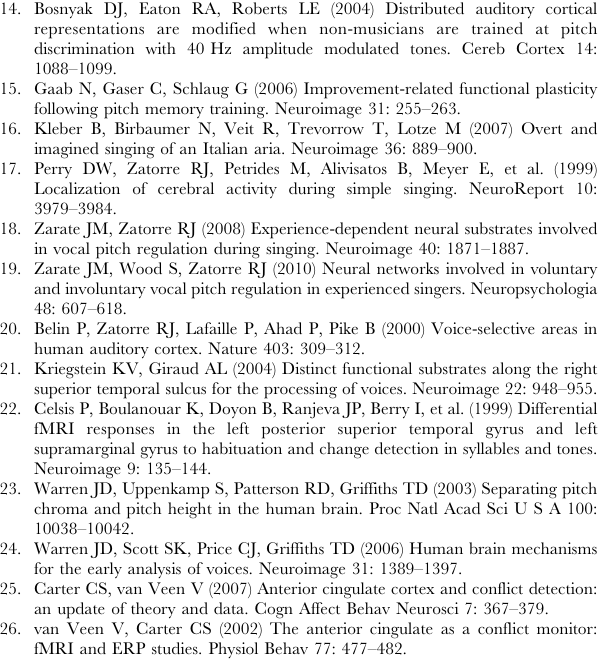
Table S2 Connectivity maps associated with right mid-dorsal insula and left ACC BA 24 during simple singing. All peak/cluster ps # 0.05, corrected. ACC = anterior cingulate cortex; BA = Brodmann area; dPMC = dorsal premotor cortex; IPL = inferior parietal lobule; L = left; M1 = primary motor cortex; mid-PMC = mid-premotor cortex; PAC = primary auditory cortex; post = posterior; pre-SMA = pre-supplementary motor area; pSTG = posterior superior temporal gyrus; pSTS = posterior superior temporal sulcus; R = right; RCZa = anterior portion of rostral cingulate zone; SMA = supplementary motor area; STG = superior temporal gyrus; STS = superior temporal sulcus; vPMC = ventral premotor